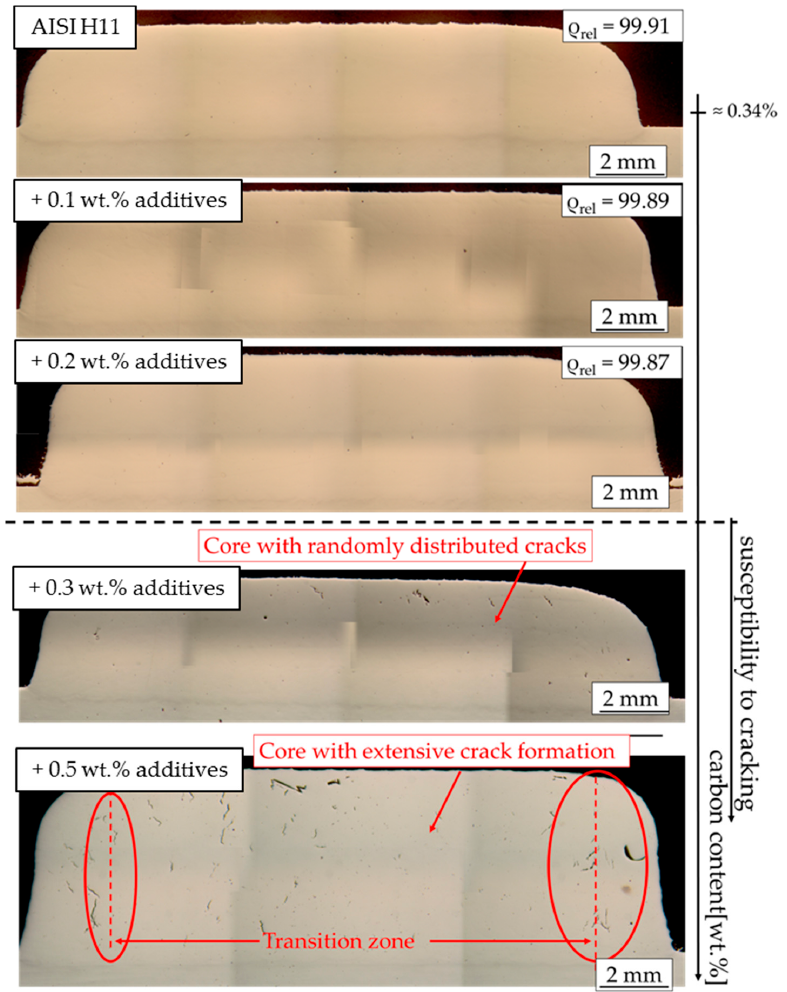
Figure 8. Polished metallographic cross sections of samples manufactured with the pure AISI powder and the modified tool steel powder mixtures with respect to the total carbon content ( P = 800 W, (cid:1865)(cid:4662) = 2.7 g/min , f rate = 400 mm/min). m = 2.7 g/min, f rate = 400